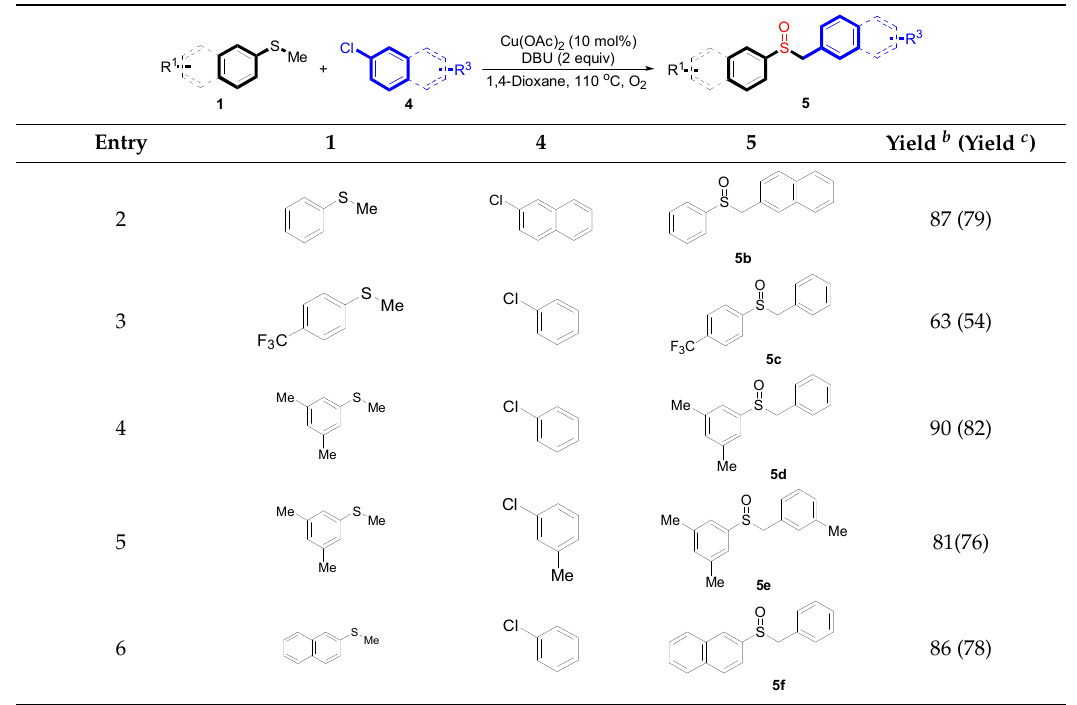
Table 3. Copper-catalyzed sulfoxidation of aromatic methyl thioethers 1 with aryl chlorides 4 a .